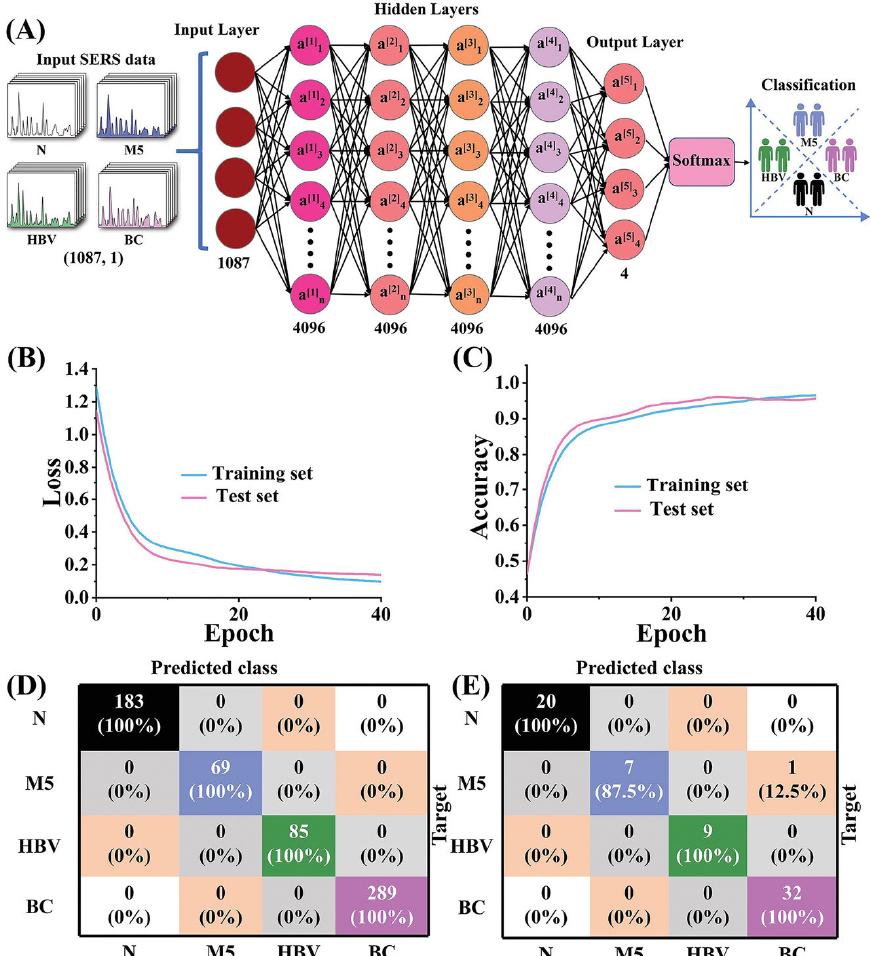
Figure 10. ( A ) Schematic of the architecture used for classification of different cancers and normal serum samples using SERS spectra collected from nearly 695 patients. ( B ) Learning curves for the model implemented with loss and ( C ) accuracy as metrics. ( D ) Confusion matrix for the training ( E ) test data sets communicating good accuracy. Reproduced with permission from [50]. Copyright (2021), Wiley.